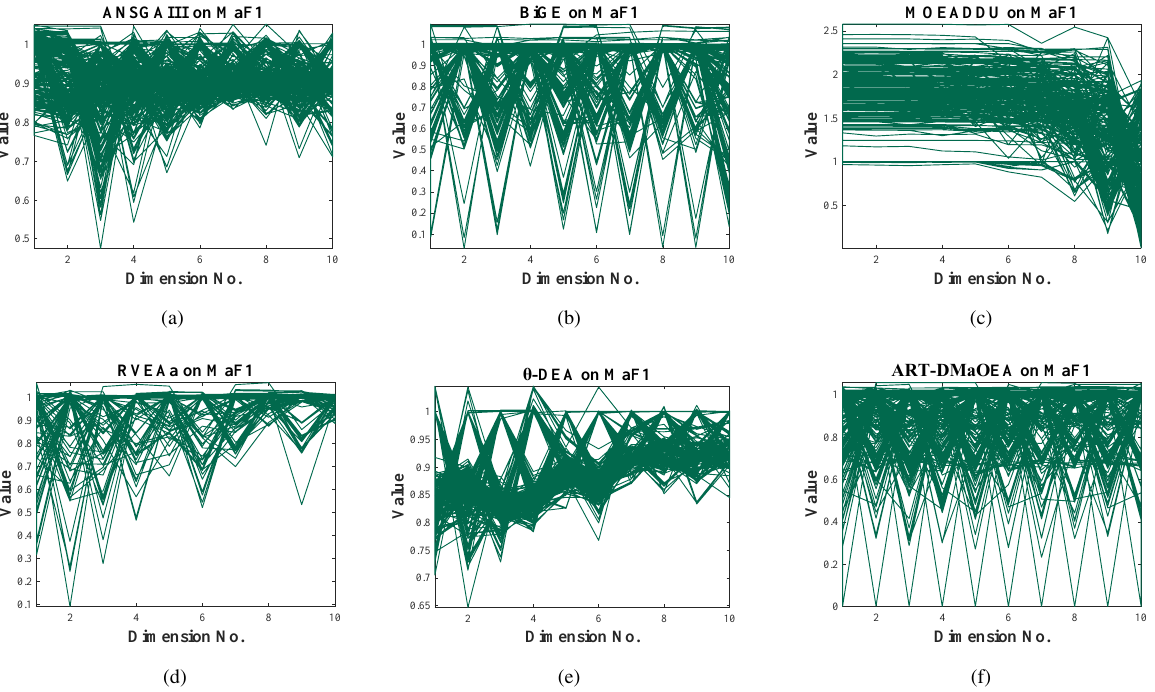
Figure 6. The best populations obtained by the six algorithms on ten-objective MaF1, as shown by Fig. 6: The final populations obtained by the six algorithms on 10-objective MaF1, shown by parallel coordinates. parallel